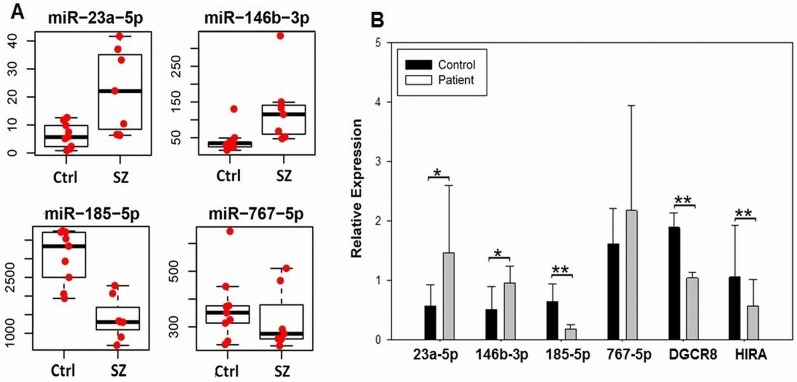
A. miRNA-seq reads (y-axis) for controls (ctrl) and patients with 22q11.2 del (SZ) showing two, nominally significant up-regulated genes (miR-23a-5p and miR-146b-3p), a miRNA that showed a genome wide significant decrease in expression (miR-185-5p), and a miRNA that showed no difference in expression (miR-767-5p). B. Same miRNAs in 2A showing qPCR analysis using Mercury LNA Universal RT microRNAs assays, as described in methods. The relative expression of two coding genes that map to the 22q11.2 del region (DGCR and HIRA) was analyzed by routine qPCR. A Student’s t-test was used for statistical analysis. Error bars show standard deviation; p<0.05, one-tailed*; p<0.05, two-tailed.**